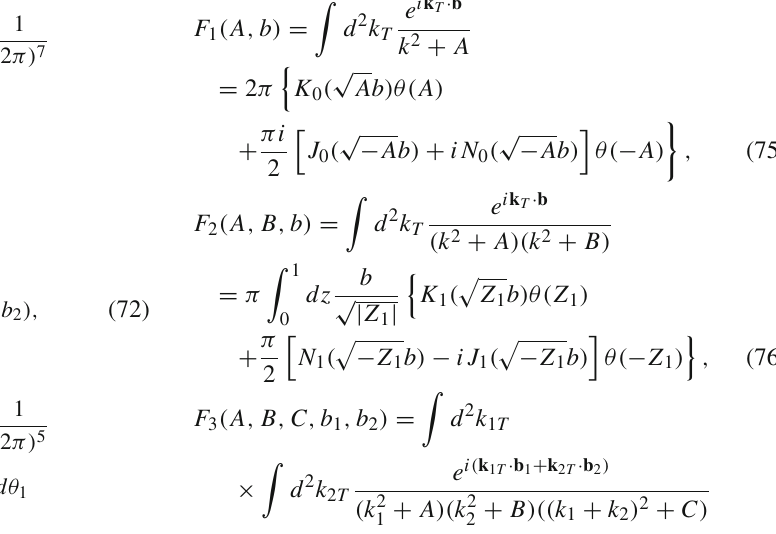
where C = 8 / 3isthecolorfactorand [ dx ] ≡ dx 1 dx 2 dx 3 δ( 1 − x 1 − x 2 − x 3 ) , [ dx (cid:4) ] is defined analogously, the auxiliary func- tions A , B , C and D in Table 13 are related to the denomi- nators of the four propagators in each diagram, and the hard kernels h are collected in Tables 14, 15 and 16. The exponent S D i is the sum of the total exponents from the (cid:2) b and proton wave functions with the hard scale t D i involved in the dia- gram D i . The functions F 1 , F 2 and F 3 are written, in terms of the Fourier integrals,